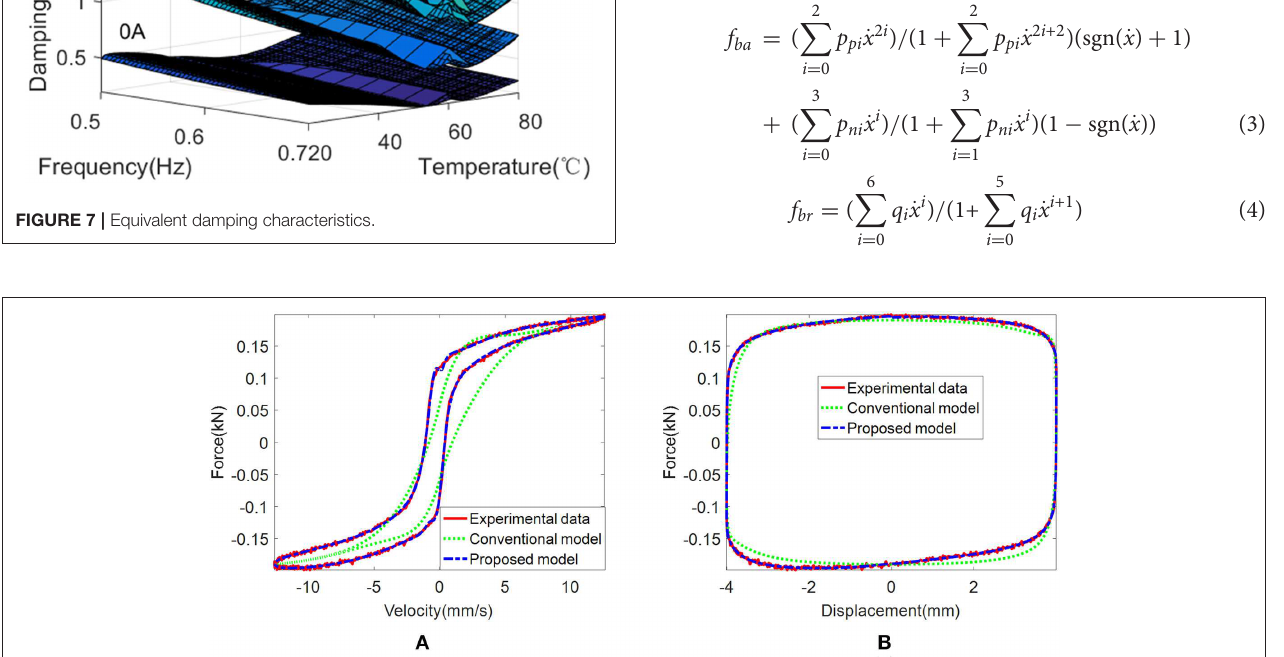
FIGURE 8 | Comparison of the experimental data and the identified results of different models. (A) Force vs. velocity. (B) Force vs. displacement.